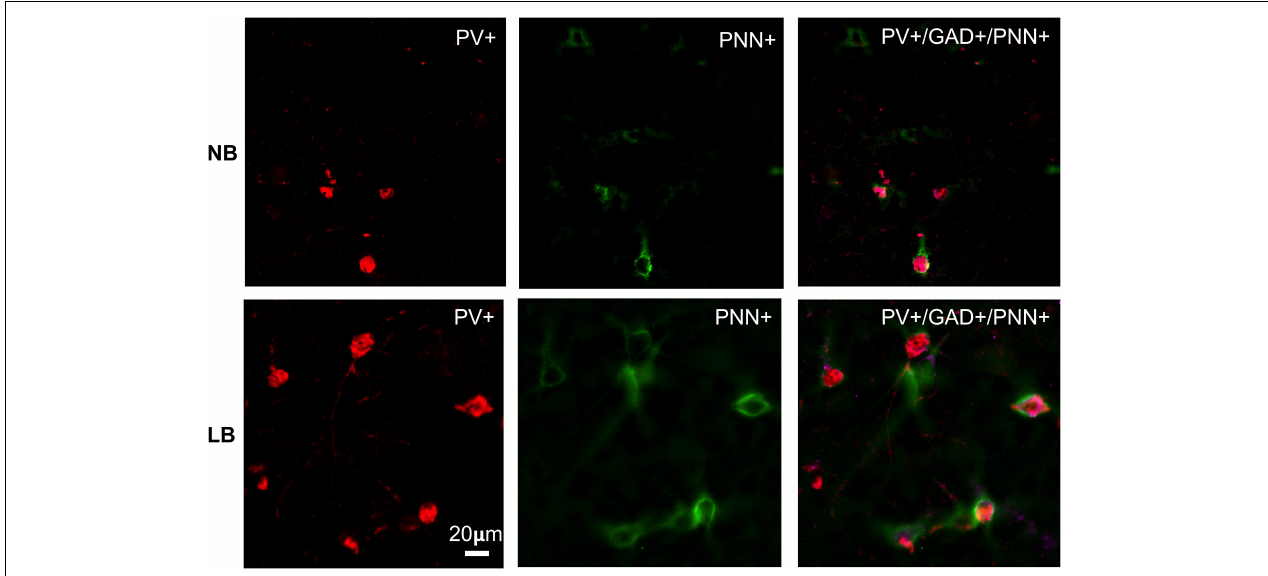
FIGURE 3 | Immunohistochemical detection of parvalbumin (PV) positive neurons in the juvenile (PND28) rat BLA that are surrounded by perineuronal nets (PNN) in offspring exposed to normal bedding (NB) or limited bedding (LB) conditions during the first 10 days of postnatal life. Note the higher density of cells co-expressing PV and PNN in the BLA of LB compared to control (NB) offspring. Images were taken on an Olympus BX63 microscope at 20x magnification. Scale bar is 20 µ m.